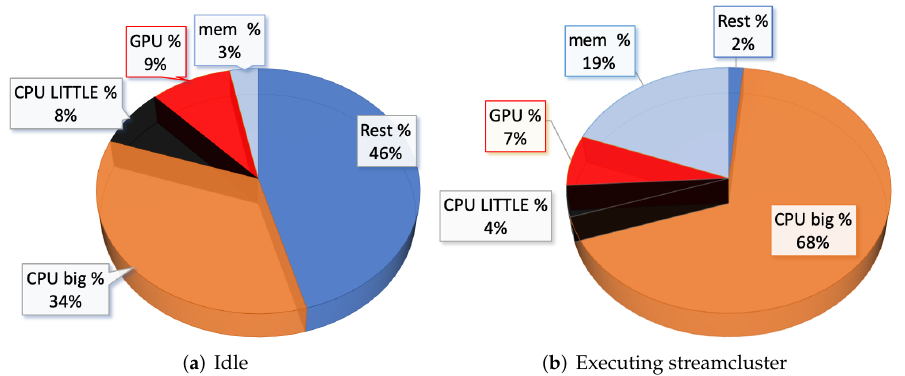
Figure 1. Percentage of average power consumed by the big CPUs, LITTLE CPUs, GPUs, memory and the rest of the components such as the fan (active cooling), hardware storage and on-chip com- munication network of the Exynos 5422 MPSoC when idle vs executing the streamcluster benchmark.